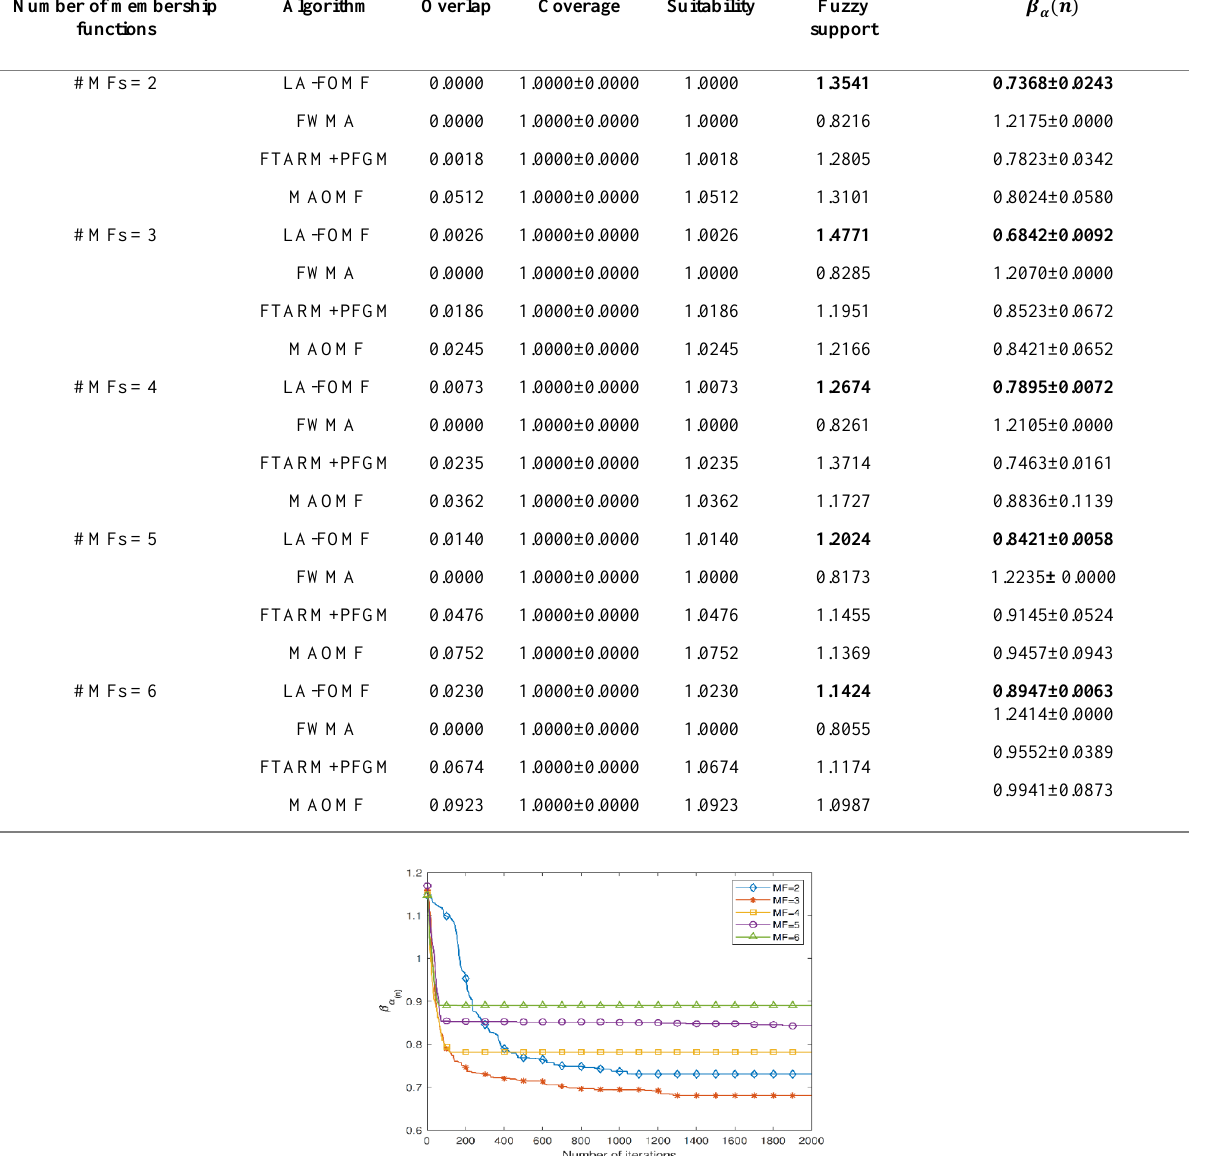
Figure 10 . Value of obtained by LA-OMF for the membership functions 2, 3, 4, 5, and